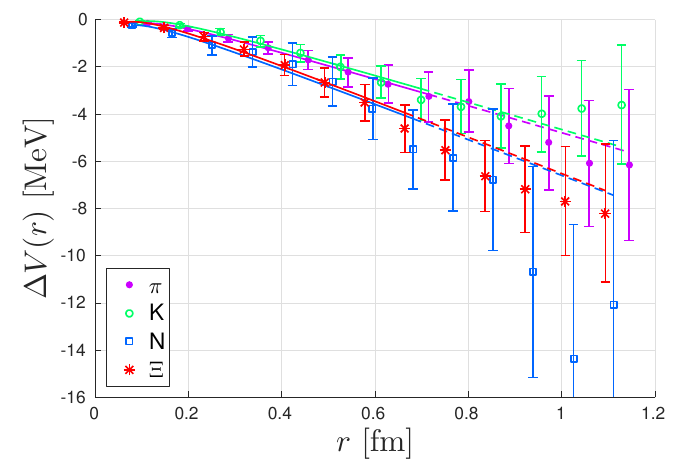
Figure 3. The modification ∆ V H ( r ) of the static potential due to the presence of a hadron [19]. The curves represent the parametrization ∆ V H ( r ) = ∆ µ H − ∆ c H / r + ∆ σ H r . The parameters ∆ µ H , ∆ c H and ∆ σ H describe the modifications to the Cornell